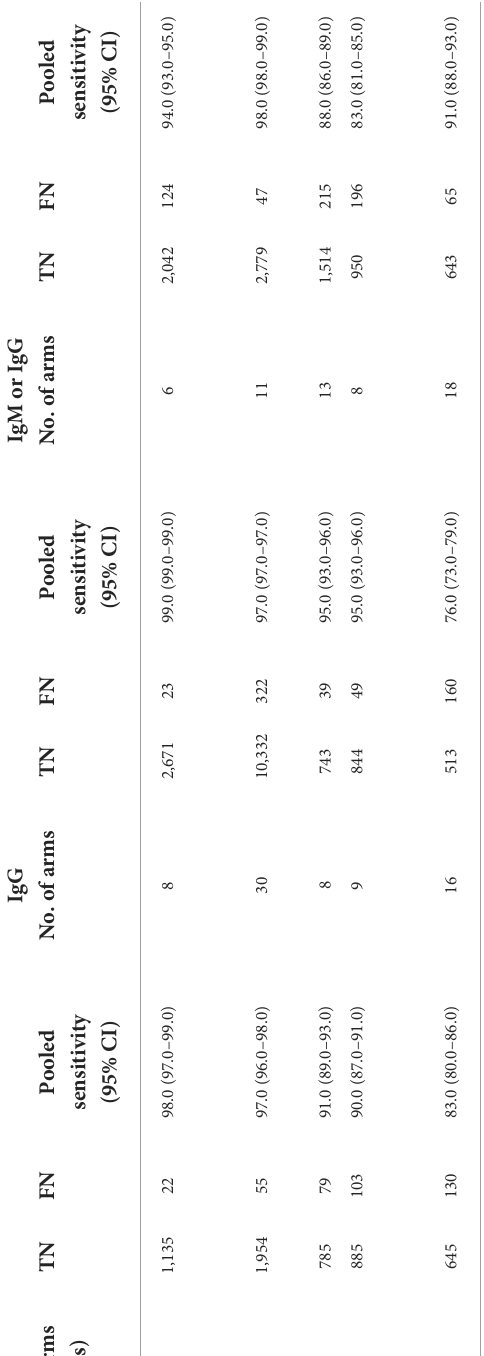
ROC curves (Supplementary Figure S1) and of the forest plots (Supplementary Figure S3) showed meta-analytical estimates of specificity (with a value of 95%) by using the serological test method and antibody